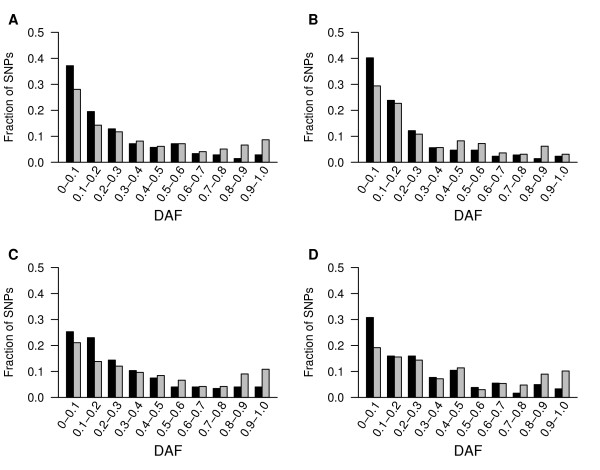
DAFs are lower for SNPs in the stems than in the loops/bulges of CSSs. Derived allele frequencies (DAFs) were calculated for predicted stems and loops/bulges and grouped in frequency bins of width 0.1 for four HapMap populations: A: CEU; B: YRI; C: JPT; D: CHB. Black and gray bars represent data for SNPs on stems and on loops/bulges of CSSs.